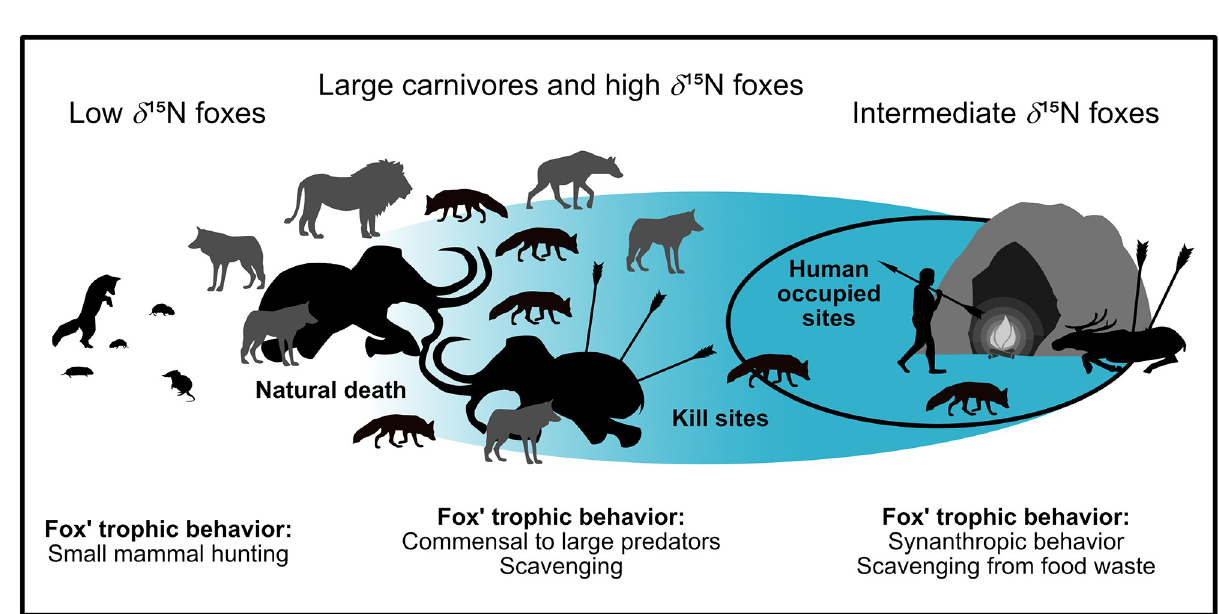
Fig 6. Summary figure for the commensal fox hypothesis. The blue area marks the impact of humans on dietary resources. For low δ 15 N foxes, humans had no influence, while for intermediate δ 15 N foxes they had a very strong influence (restricted diet). High δ 15 N foxes may be influenced (e.g. by scavenging at kill sites) or may be of natural origin (e.g. by scavenging from megafauna that died